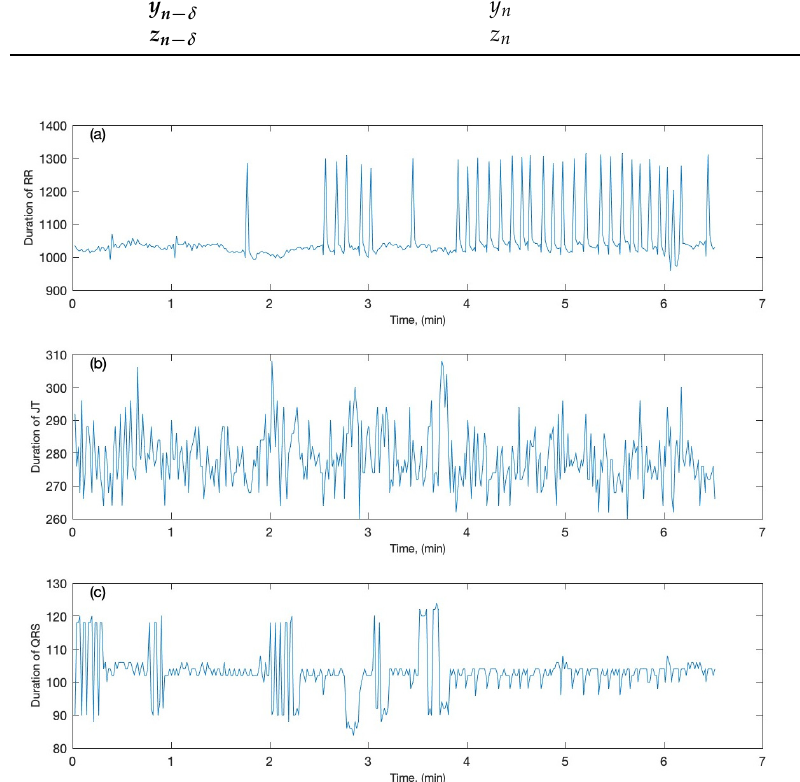
Figure 2. The three recorded cardiac intervals are plotted as time series (the time is in minutes): ( a ) the RR interval; ( b ) the JT interval; ( c ) the QRS